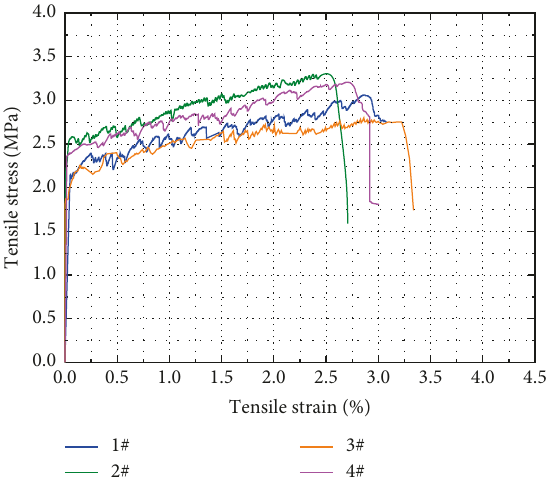
Figure 5: Typical stress-strain curves for ECC with different mix